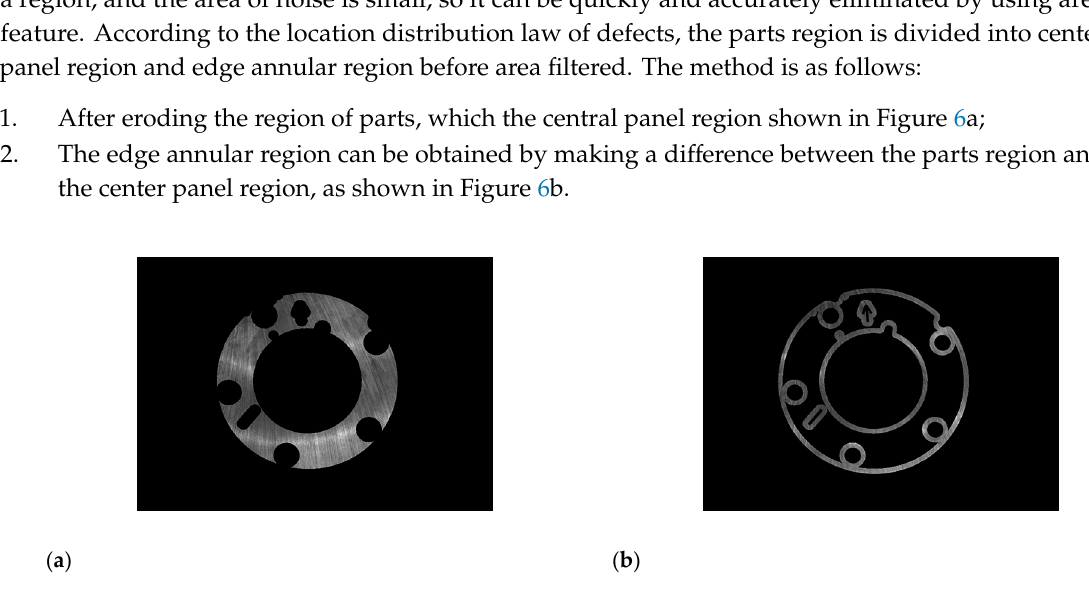
Figure 6. Division of parts: ( a ) the central panel region; ( b ) the central panel region.